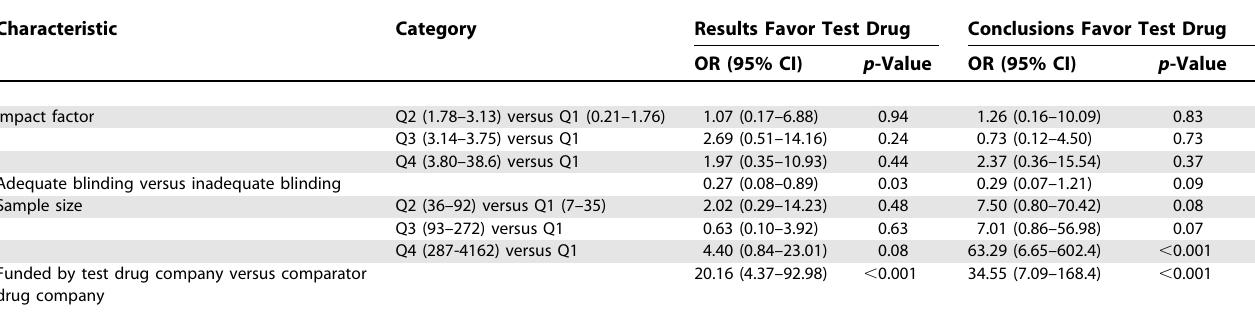
Table 5. Association between Characteristics of Industry-Funded Manuscripts ( n ¼ 95) and Results or Conclusions that Favor Test Drug: Multivariate